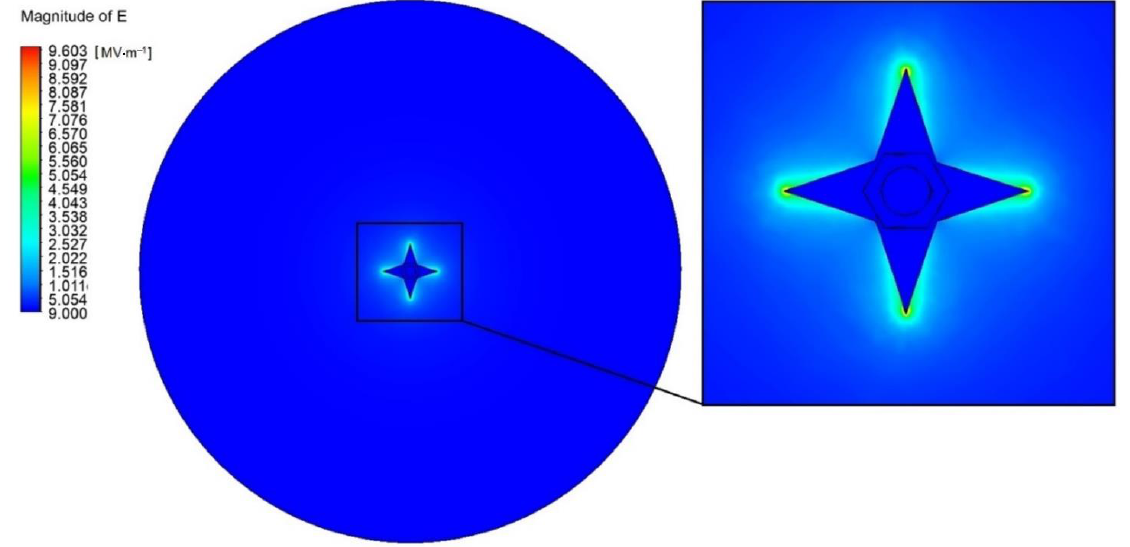
Figure 8. Range of electric field intensity on the electrode with spikes by numerical simulation.